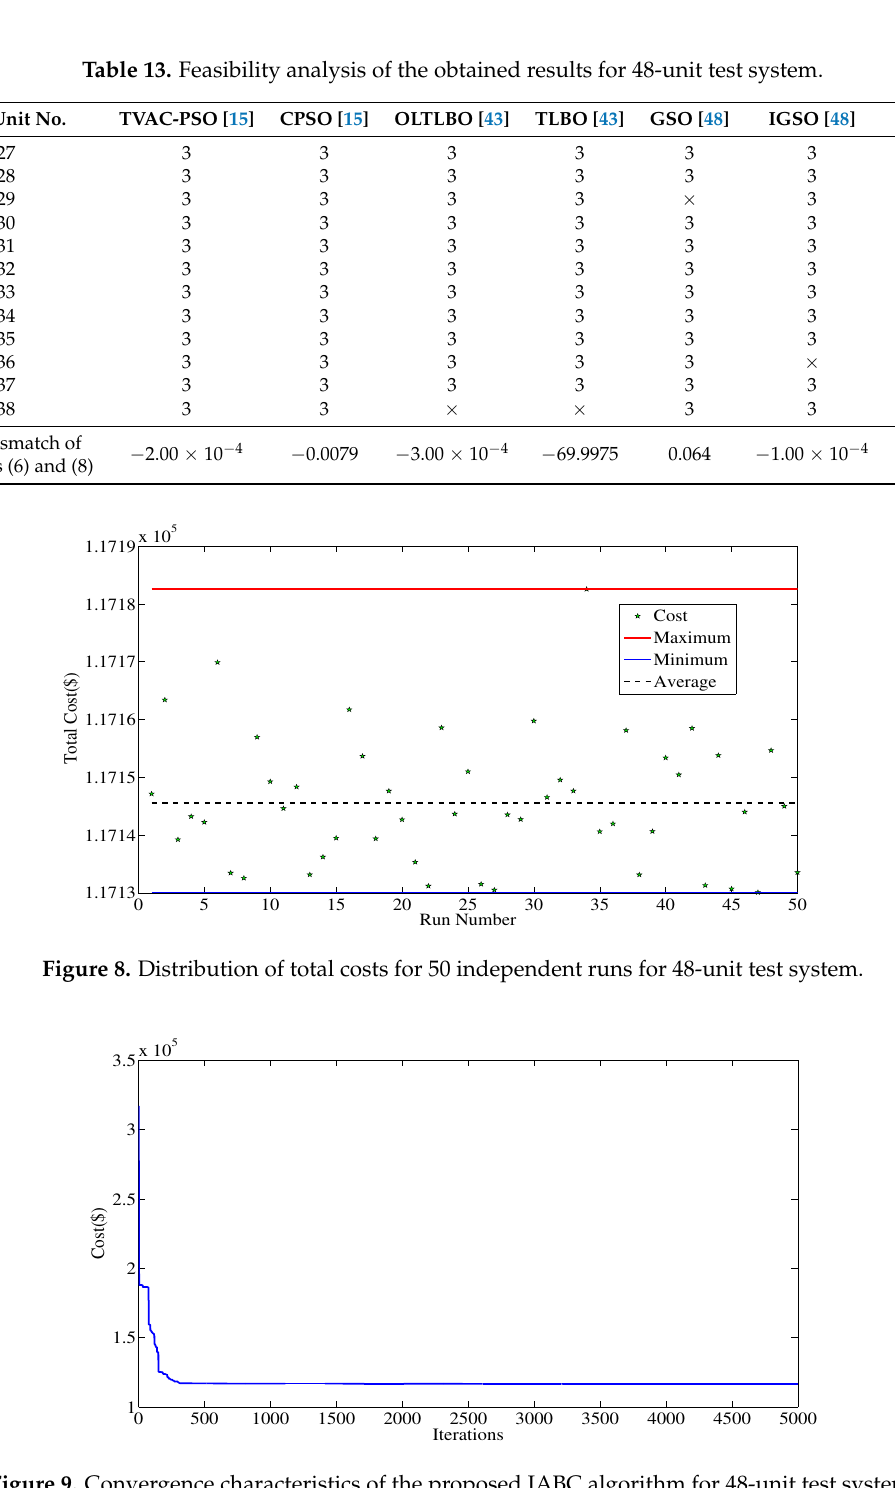
Figure 9. Convergence characteristics of the proposed IABC algorithm for 48-unit test